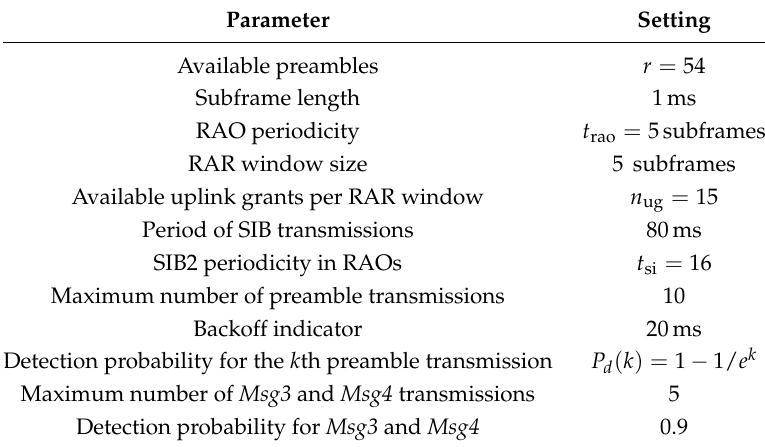
Table 2. Parameters for the selected network